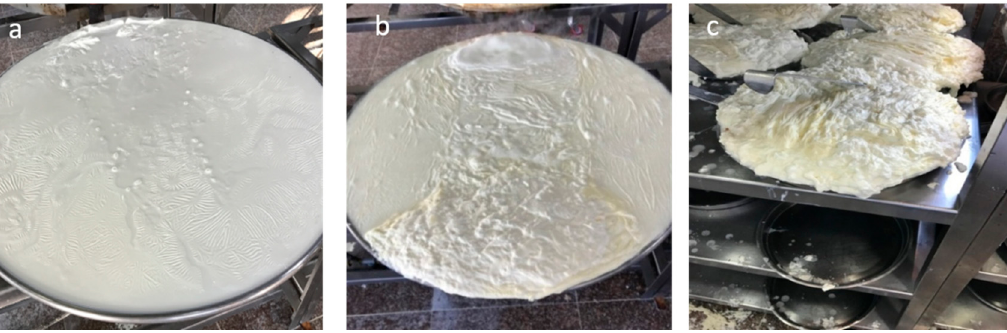
Figure 2. ( a ) Skin formation ( b ) Aggregates gathering ( c ) Qishta drainage.